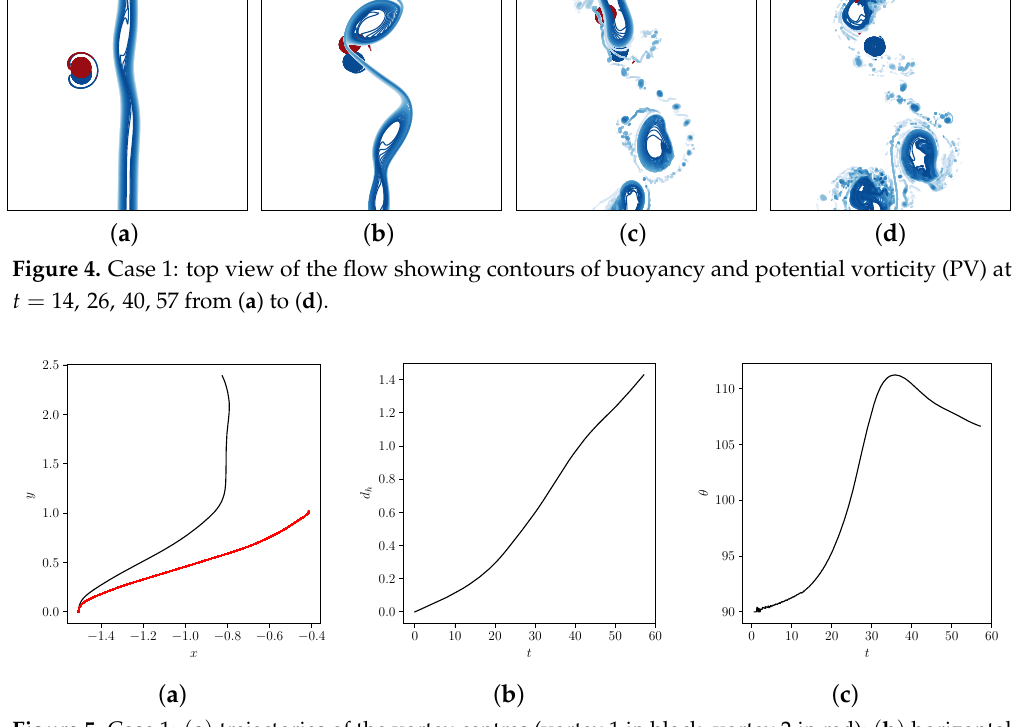
Figure 5. Case 1: ( a ) trajectories of the vortex centres (vortex 1 in black, vortex 2 in red); ( b ) horizontal distance between the vortex centres d h versus time t ; and ( c ) angle between the axis joining the vortices centres and the x